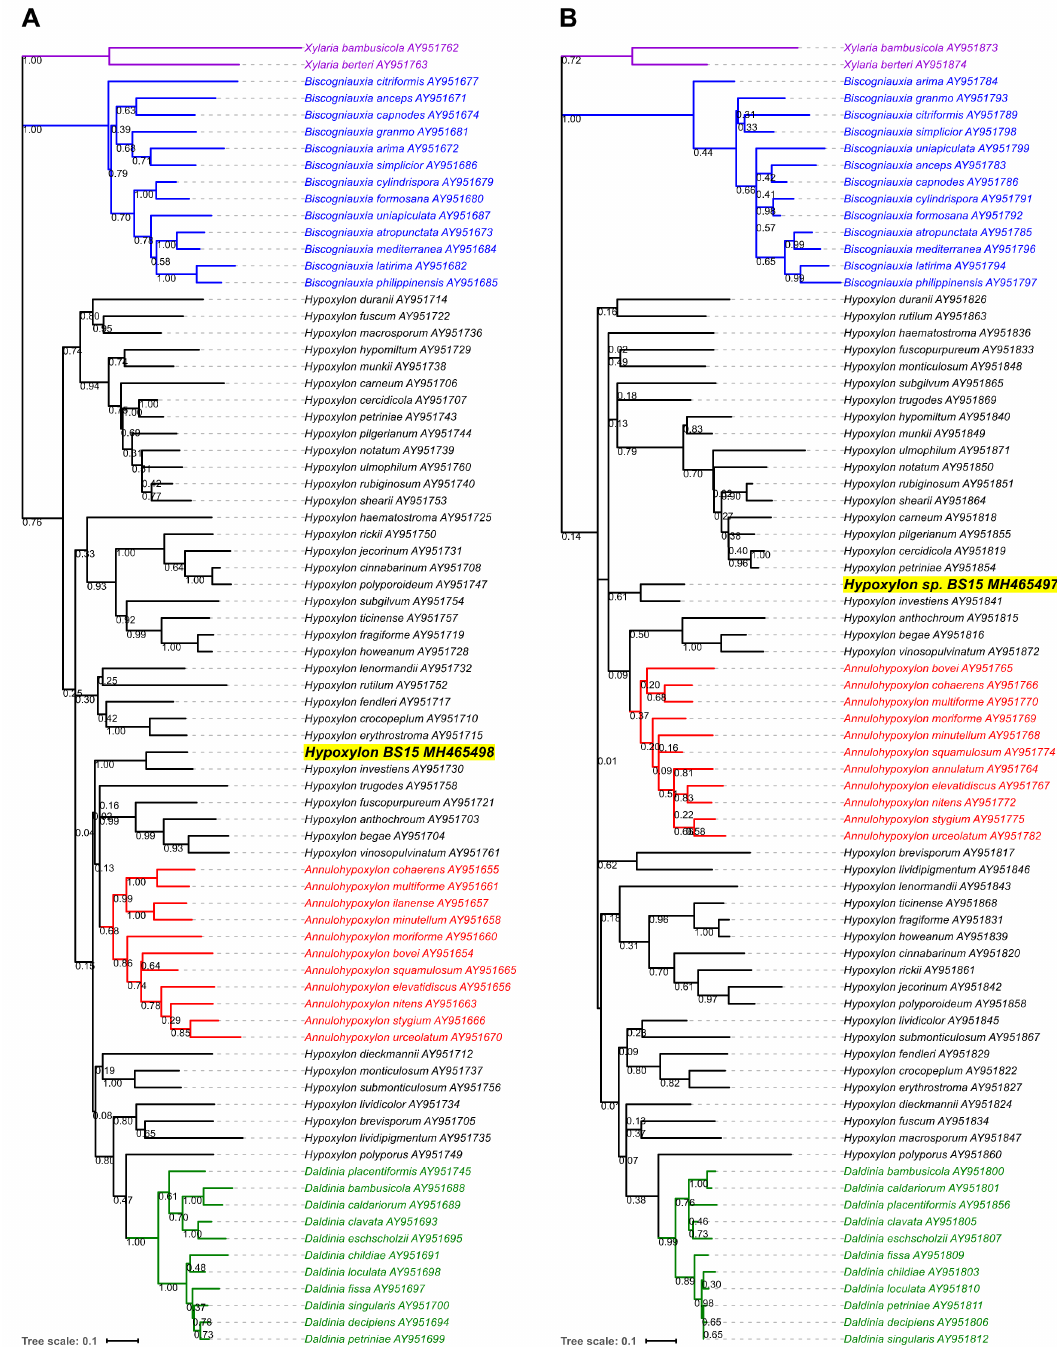
Figure 3. Phylogenetic reconstruction of Hypoxylon sp. BS15 and related organisms generated from maximum likelihood clustering of MUSCLE-aligned protein-coding gene sequences. A total of 78 sequences were analyzed for α -actin ( A ) and β -tubulin ( B ). The branch lengths are shown to scale, representing the average number of nucleotide substitutions per site between sequences. The bootstrap values at the nodes are from 1000 bootstrap